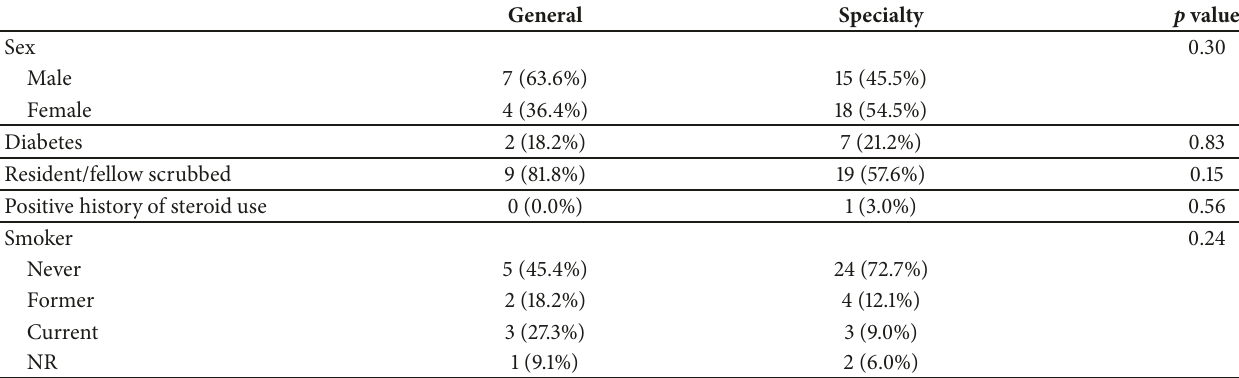
Table 6: Demographic variables at general university versus dedicated orthopaedic hospital for THA PJIs. Demographic variables, such as BMI, sex, diabetes, whether a resident/fellow was scrubbed, positive history of steroid use, and smoking status were examined at the general university versus dedicated orthopaedics specialty hospitals. NR = not reported. p value was calculated by X 2